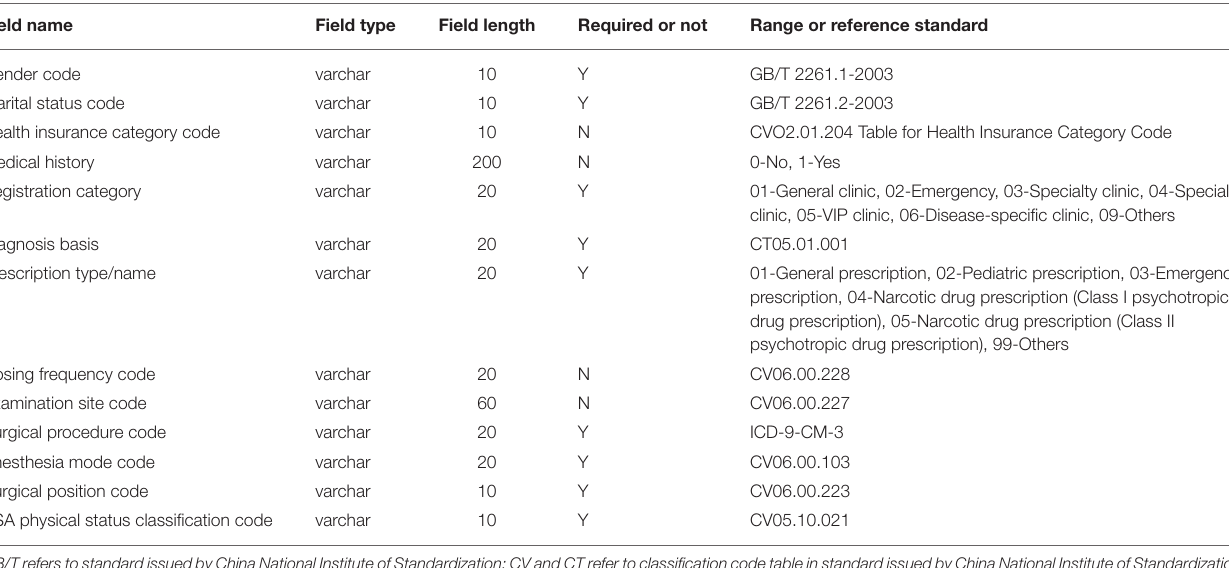
TABLE 4 | Partial attributes of some standard data elements.